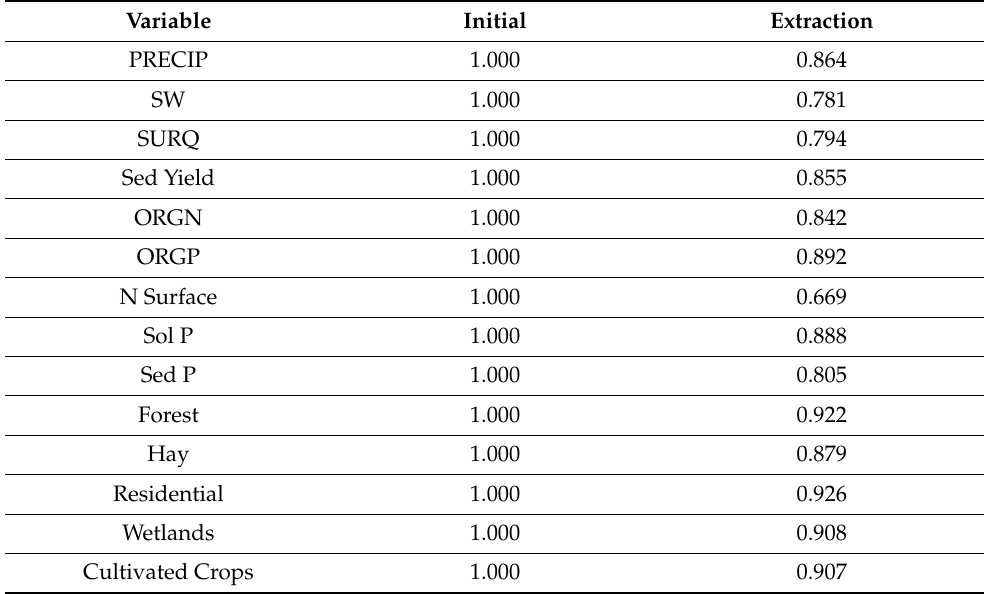
Table A9. Communalities values extracted from the principal components analysis